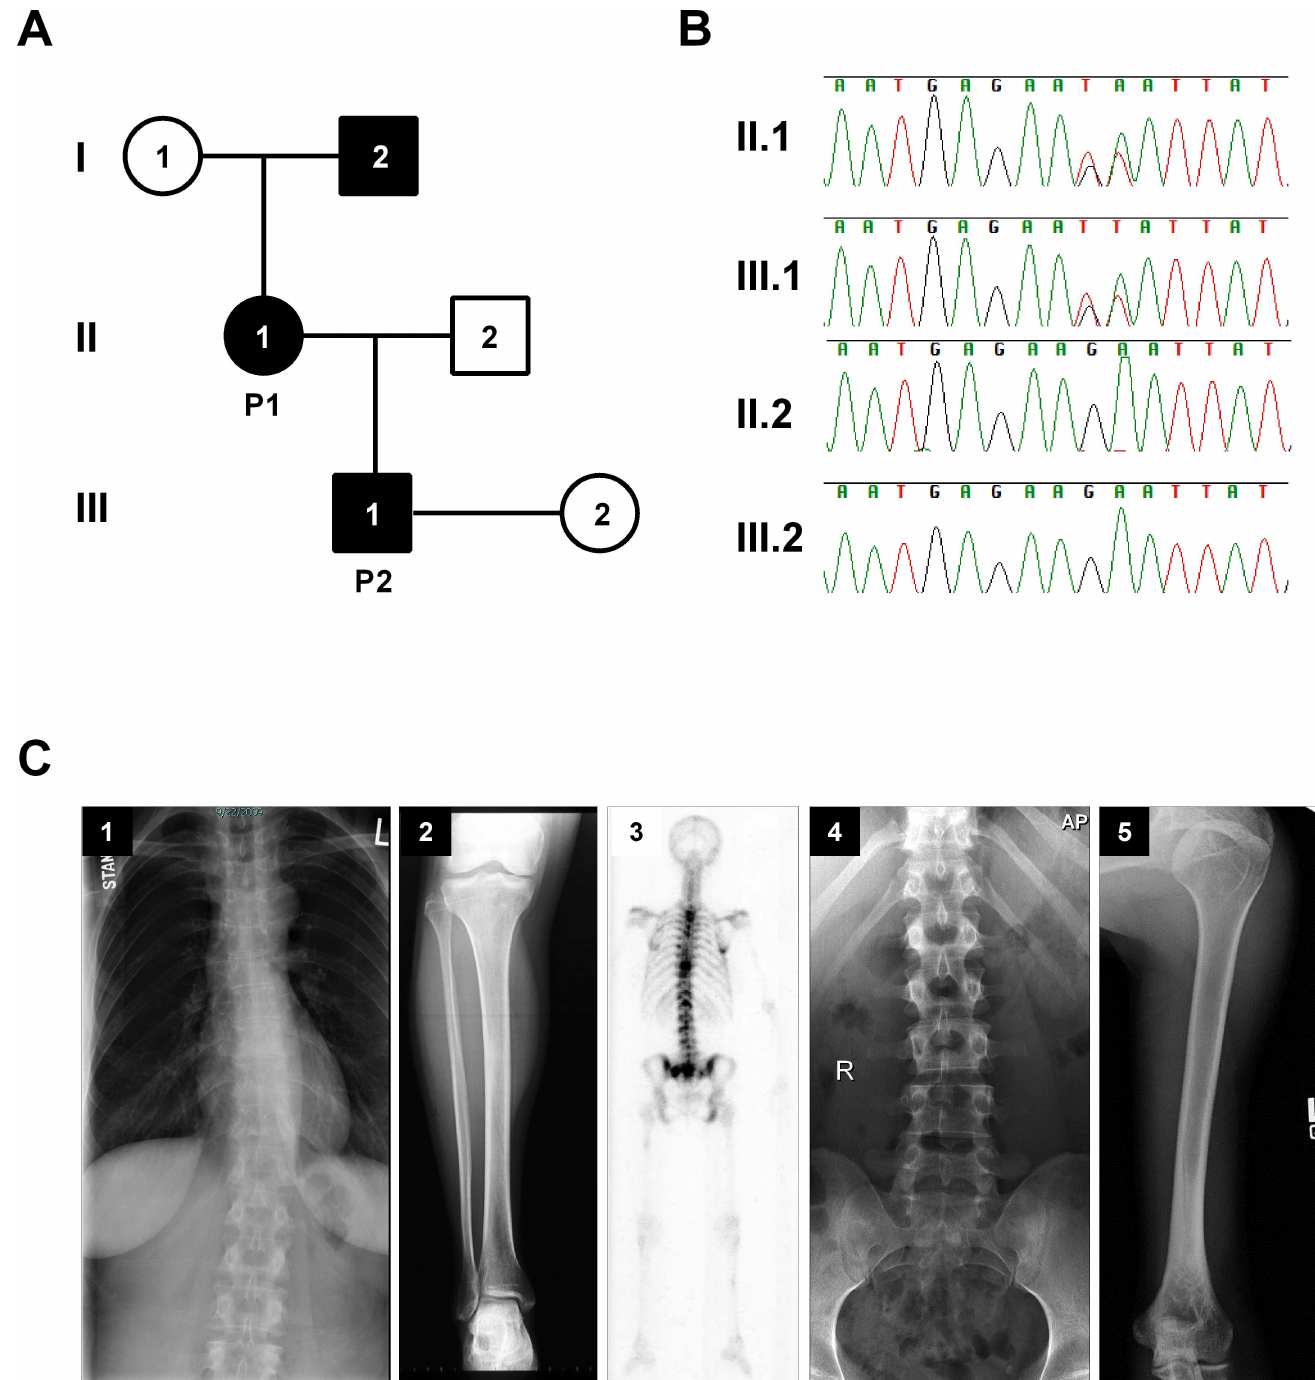
Fig 1. Clinical featuresof patients with ATP6V1H mutations. The family comes from a three-generation pedigree;affected members are shaded in black ( A ); Chromatograms showingthat the ATP6V1H mutation is present in affected family members, (II.1 and III.1 ( B ); DNA from I.1 is not available; (C) Radiographs ( C ) from Patient 1 (P1) (1, 2, and 3) and Patient 2 (P2) (4, and 5) revealthat P1 has scoliosis(C1) and increasedradiolucencyin tibia (C2). Bone scan shows multiplesites of increasedbone mineral density uptake–tipof right scapulaand multiple areas of thoracic and lumbar spine, sacrum, both sacroiliac joints, left humeral head, shaft of left femur, right tibia and right ribs (C3). Some increasein radiolucency especiallyin the lumbar spine (C4), is seen in P2.